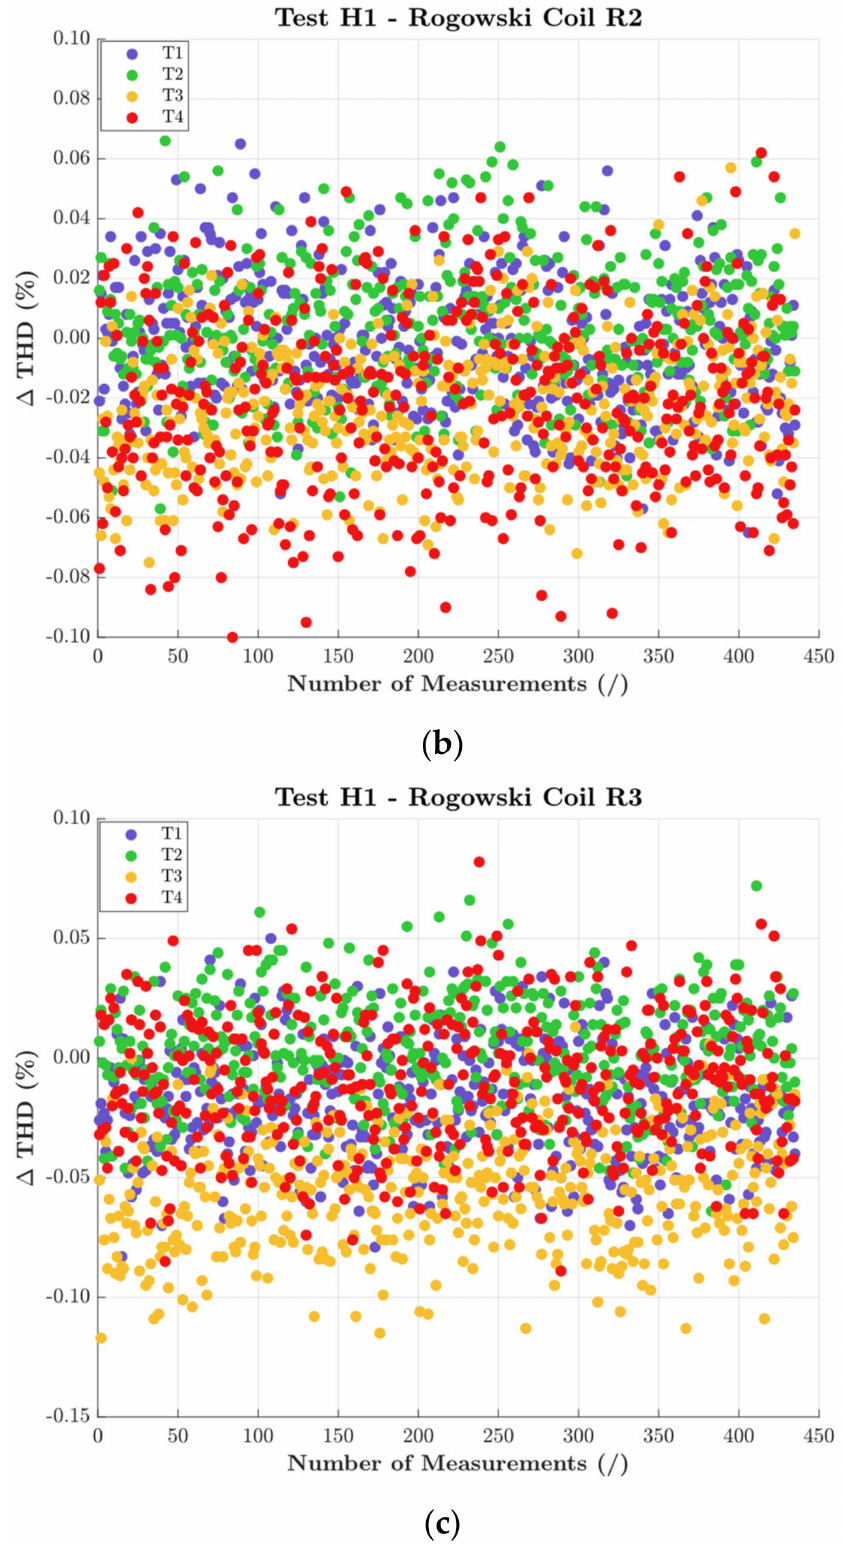
Figure 7. THD variations obtained with H1 and all positions, for ( a ) R1, ( b ) R2, and ( c )